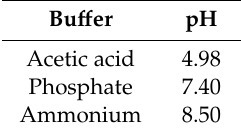
Table 3. Degradation medium